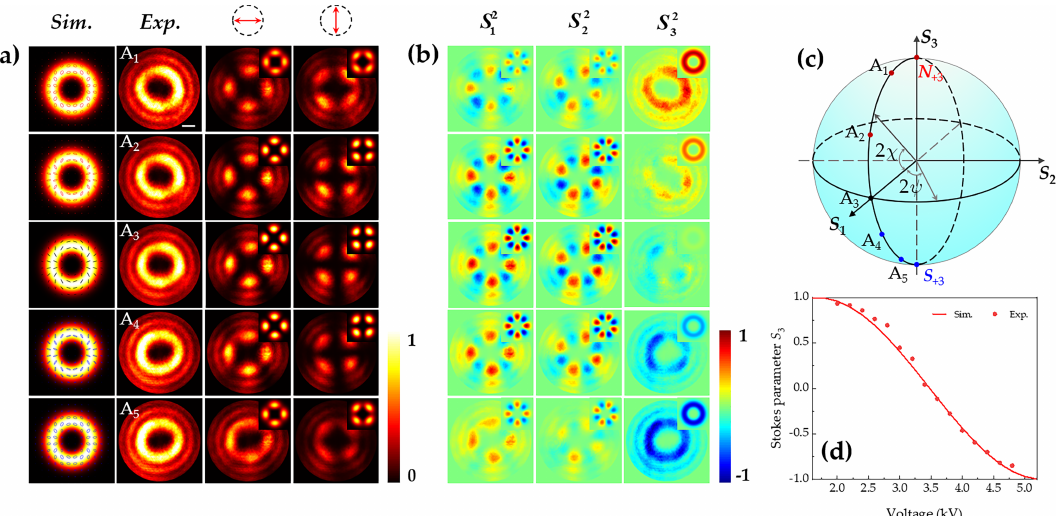
Figure 2. Simulated and experimental results of generated cylindrical VBs along longitude of HOP sphere l = + 2 with 2 ψ = 0. ( a ) Intensity pattern of generated cylindrical VBs from A1 to A5, when the applied voltage on C1 is 2.2, 2.8, 3.4, 4.0, and 4.6 kV, respectively. The first and second rows show the simulated and experimental intensity pattern with no polarizer, respectively. Polarization states are overlaid on simulated intensity pattern. The other two rows show the intensity pattern measured in experiments when the polarizer is along horizontal and vertical directions, respectively, and the corresponding simulated results are shown in insets. ( b ) Stokes parameters distribution of A1 to A5, respectively. ( c ) HOP of l = + 2. The position of generated cylindrical VBs on the HOP sphere is labeled by A1 to A5 along longitude with 2 ψ = 0. ( d ) Curve of Stokes parameter S 3 and applied Voltage U 1 , the solid line and dots denote simulated and experimental result, respectively. Scale bar in the first experimental intensity pattern of A1 represents 0.645